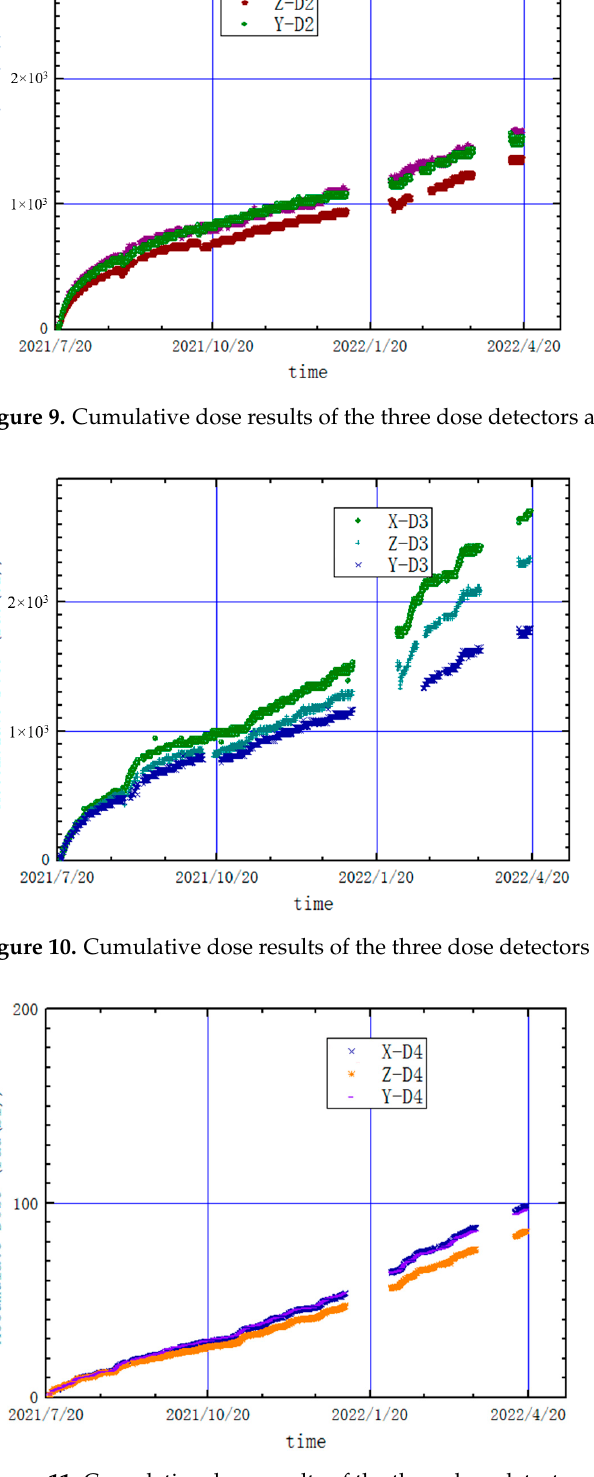
Figure 11. Cumulative dose results of the three dose detectors at monitoring point D4.